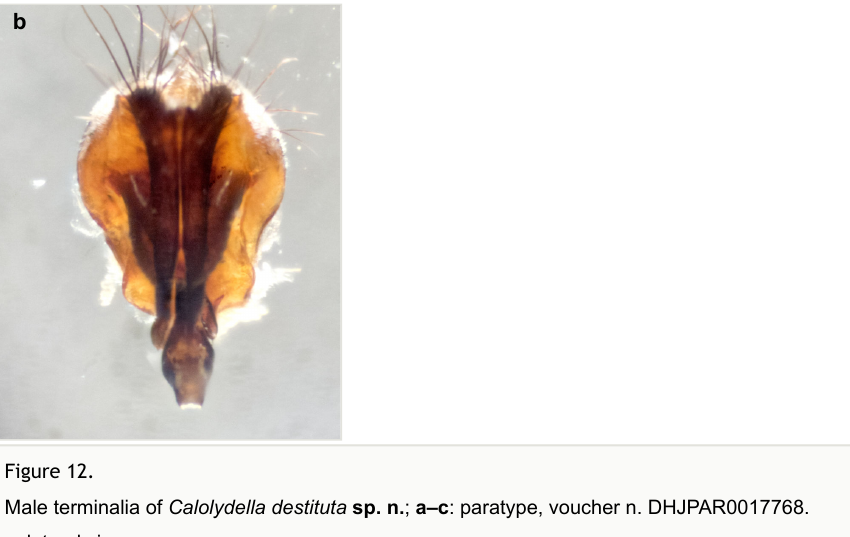
Female (Fig. 11d, e, f). Length: 5–6mm. As male, except for the following characters: fronto-orbital plate 2X as wide as in male; and T3 with one pair of median marginal setae and one pair of discal setae.